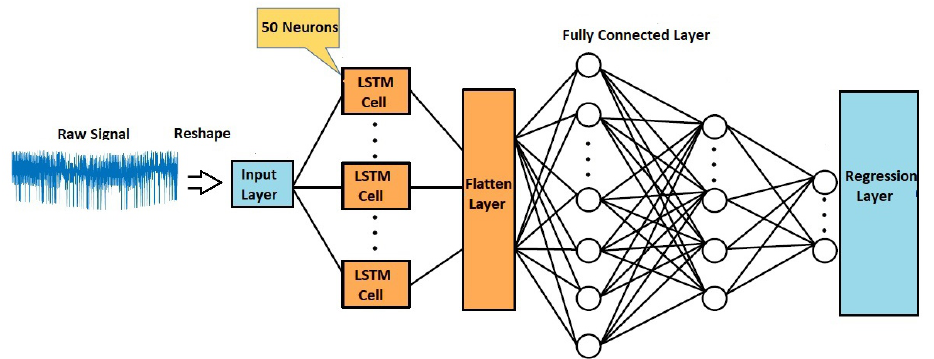
Figure 7. Layers of the